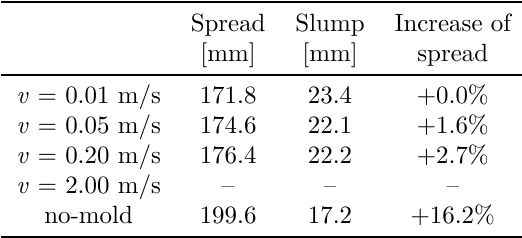
Table 1. Results of spread and slump calculated with di ff erent mold lifting velocities and no-slip